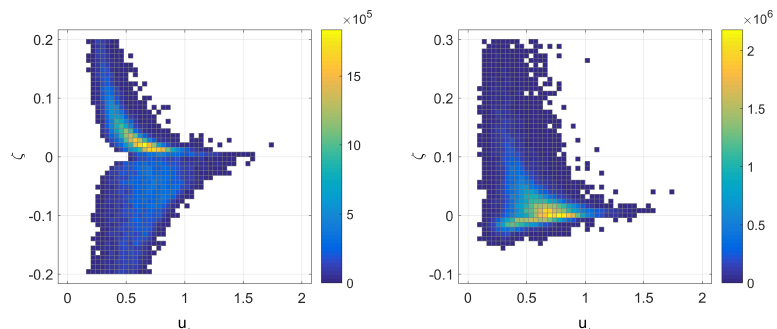
Figure 5. u ∗ and ζ distribution for two different approaches. ζ was calculated with MOST on the ( left ) and Ri b on the ( right ) illustration.